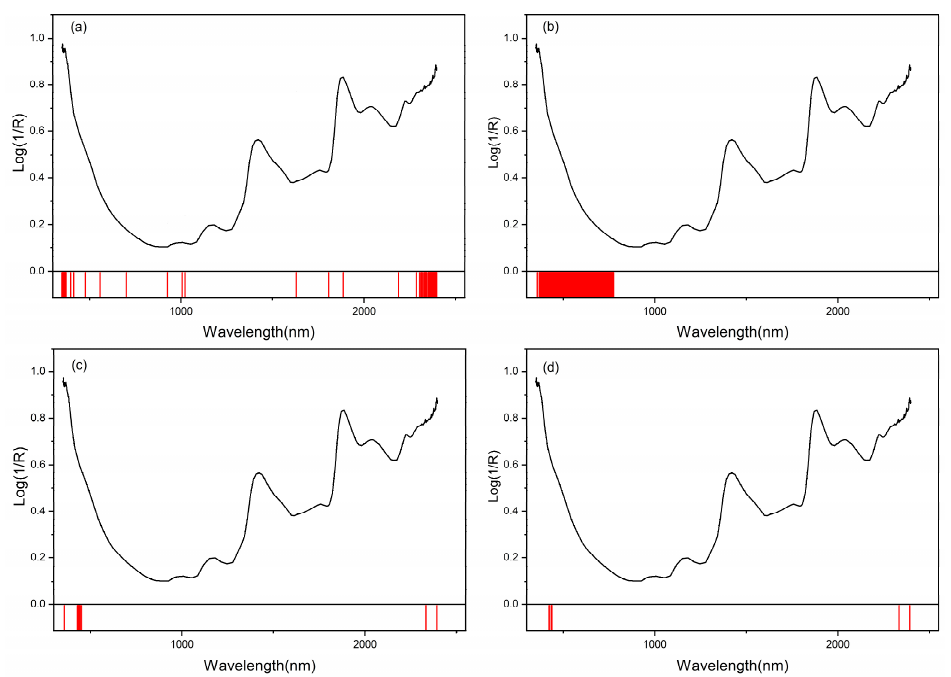
Figure 6. The distributions of the selected wavelength variables for each method. ( a ) SPA; ( b ) UVE; ( c ) CARS; ( d ) IRIV.